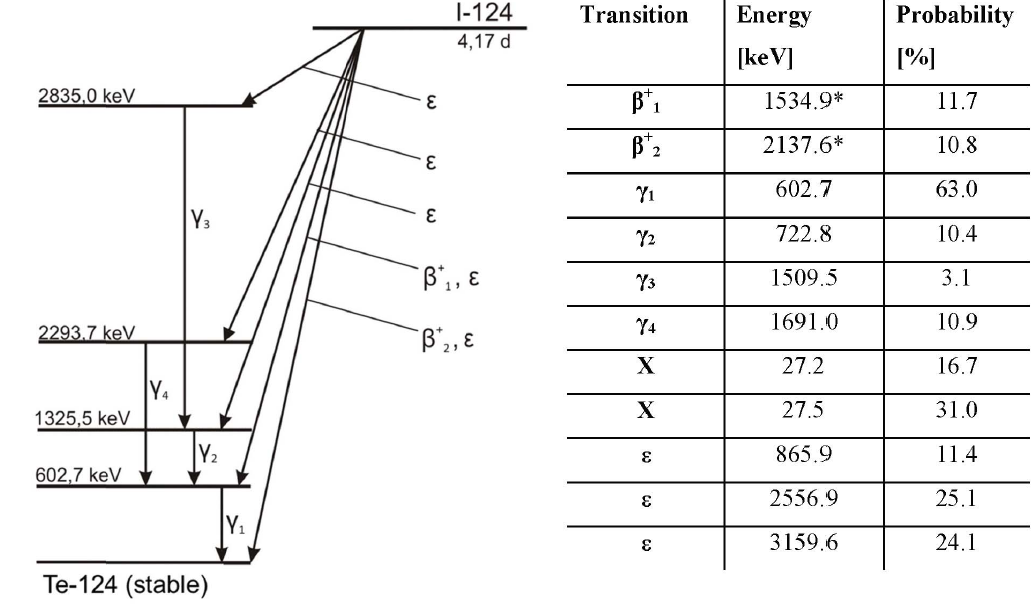
Figure 1. Simplified decay scheme of I-124 with a transition probability . 3%, *maximal energy ( b + : positron emission, c : gamma emission, X: x-ray emission, e : electron capture).